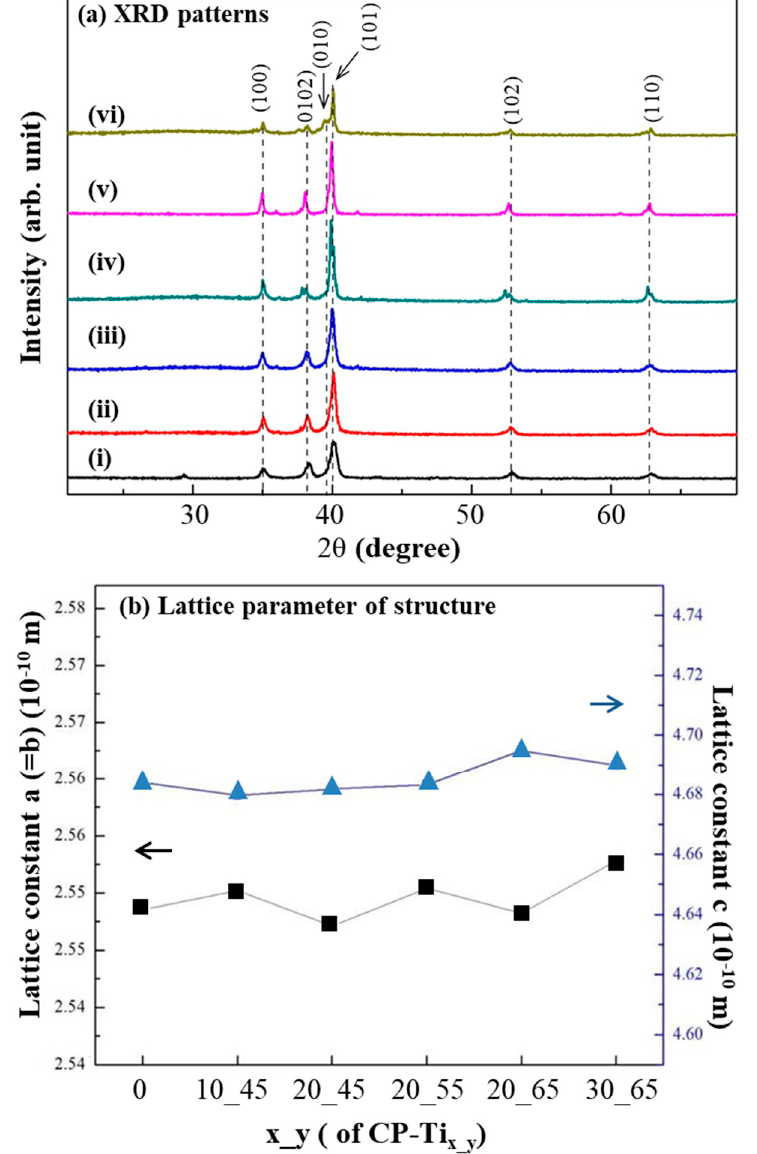
Figure 4. ( a ) X-ray diffraction (XRD) patterns from the surfaces of: (i) CP-Ti, (ii) CP-Ti 10_45 , (iii) CP-Ti 20_45 , (iv) CP-Ti 20_55 , (v) CP-Ti 20_65 , and (vi) CP-Ti 30_65 . No obvious difference of their XRD pattern was resulted. ( b ) Lattice constants a and c from the above samples were also calculated without significant difference.